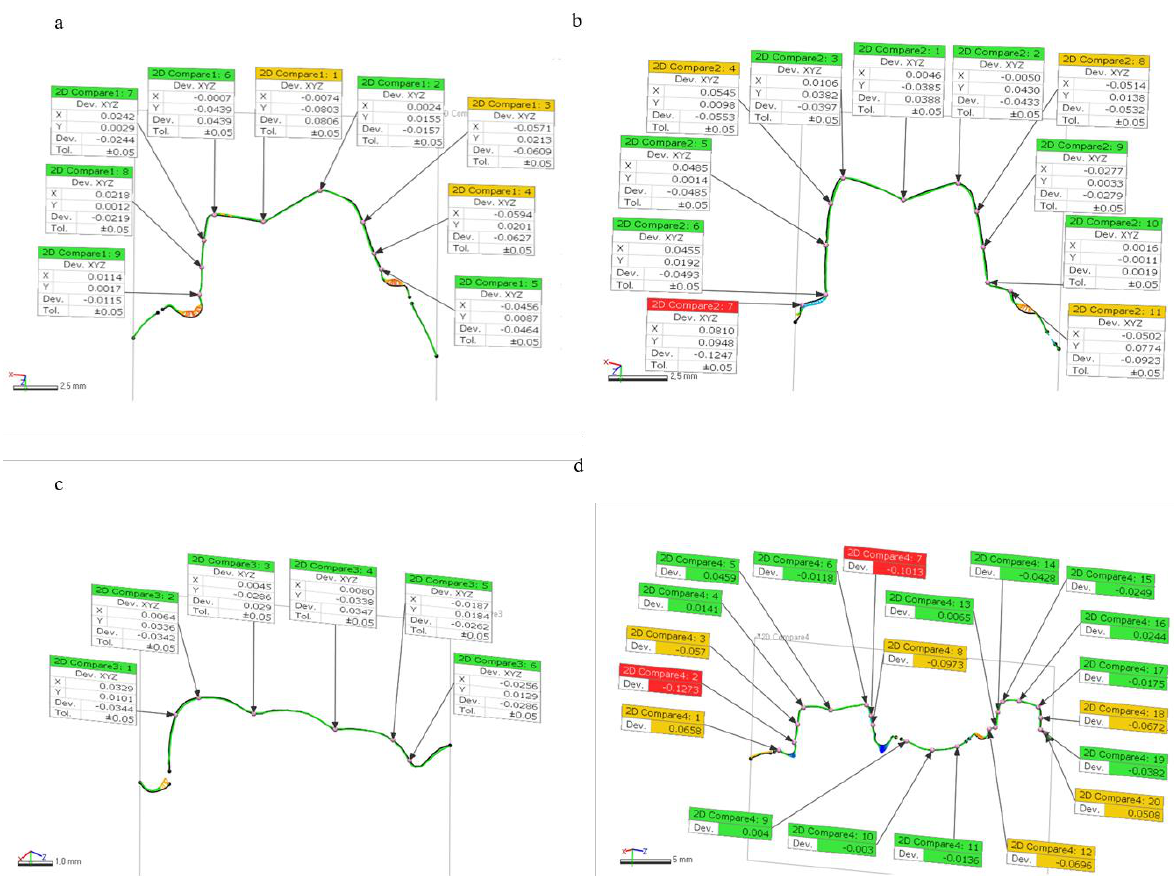
Figure 5. Measurements of deviations in two-dimensional (2D) planes. ( a ) Marginal deviations of molar teeth at a buccolingual plane. ( b ) Marginal deviations of premolar teeth at a buccolingual plane. ( c ) Deviations at proximal contact to approximate tooth. ( d ) Marginal deviations of molar and premolar teeth at a mesiodistal plane.